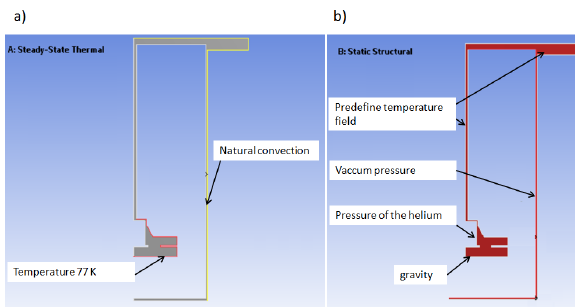
Figure 4: The boundary conditions a) thermal boundary conditions, b) mechanical boundary